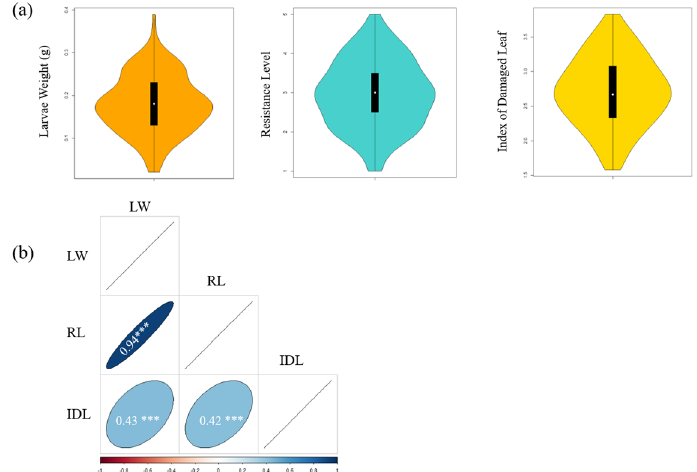
Figure 2. Phenotype distribution and correlation. ( a ) Violin plots of three traits. ( b ) Pearson correlation between the larval weight (LW), resistance level (RL) and index of damaged leaf (IDL). The number in the color circle represents the correlation coefficient; *** p < 0.001.